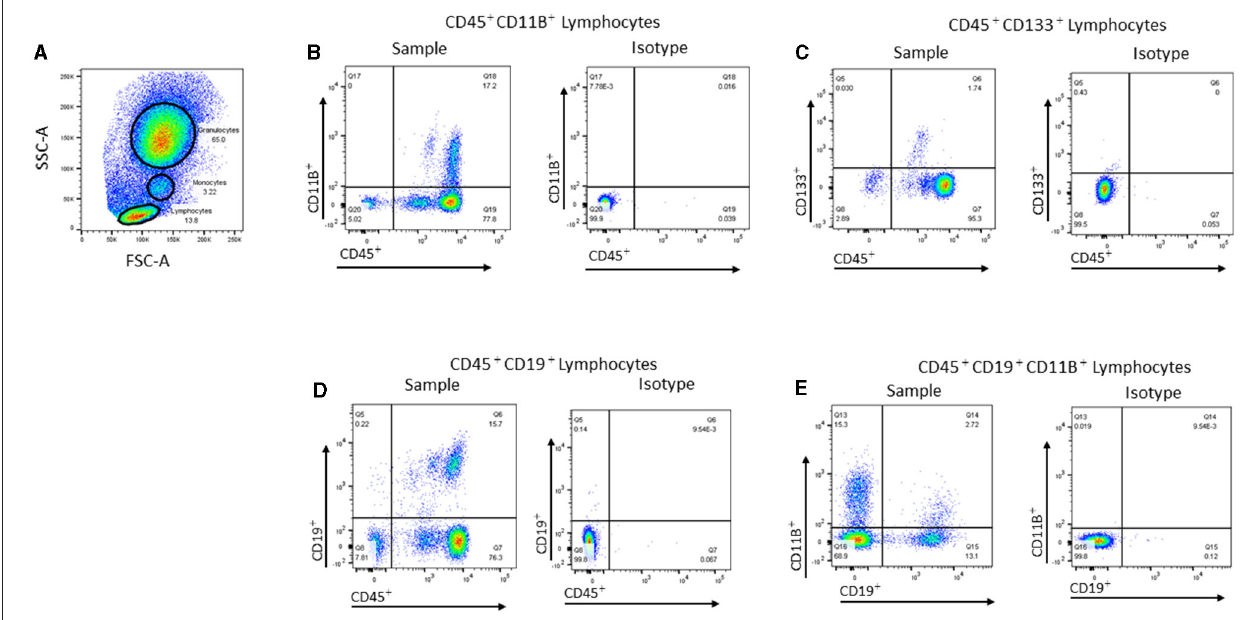
FIGURE 2 | Representative flow cytometric gating strategies used for analyzing peripheral blood cell populations. (A) Representative dot plot showing the gates used to identify lymphocytes, monocytes, and granulocytes in the peripheral blood (PB) based on forward scatter (FSC-A) vs. side scatter (SSC-A). (B) Representative dot plot showing CD45 + CD11B + cells within the monocyte gate and the corresponding isotype control. (C) Representative dot plot showing CD45 + CD133 + cells within the lymphocyte gate and the corresponding isotype. (D) Representative dot plot showing CD45 + CD19 + cells within the lymphocyte gate and the corresponding isotype. (E) Representative dot plot showing CD19 + CD11B + within the lymphocyte gate and the corresponding isotype.